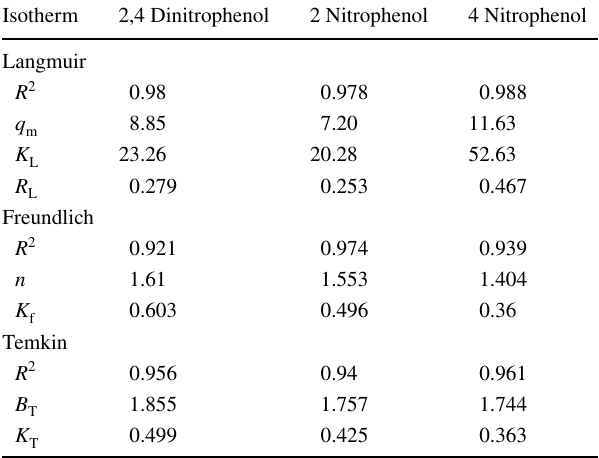
Table 2 Linear adsorption constants for the applied two-parameter adsorption